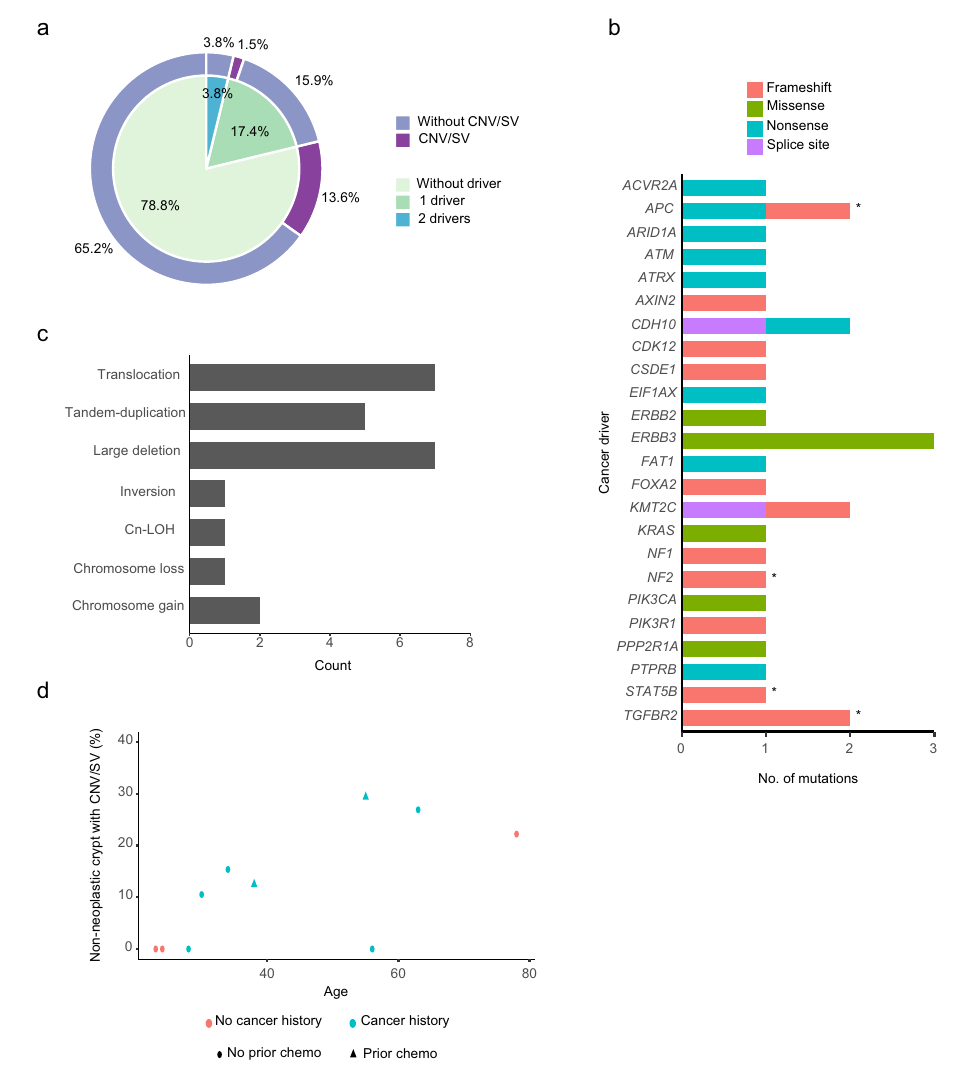
Fig. 2 Genomic stability in the non-neoplastic crypts in LS patients. a Distribution of non-neoplastic crypts with driver mutations and copy number or structural variants. b Driver mutations in non-neoplastic crypts. Asterisks denote frameshift mutations at microsatellite regions (repeat length ≥ 5). c Copy number variants and structural variants in non-neoplastic crypts. Cn-LOH: copy number neutral loss of heterozygosity. d Percentage of non-neoplastic crypts with copy number or structural variants in each LS